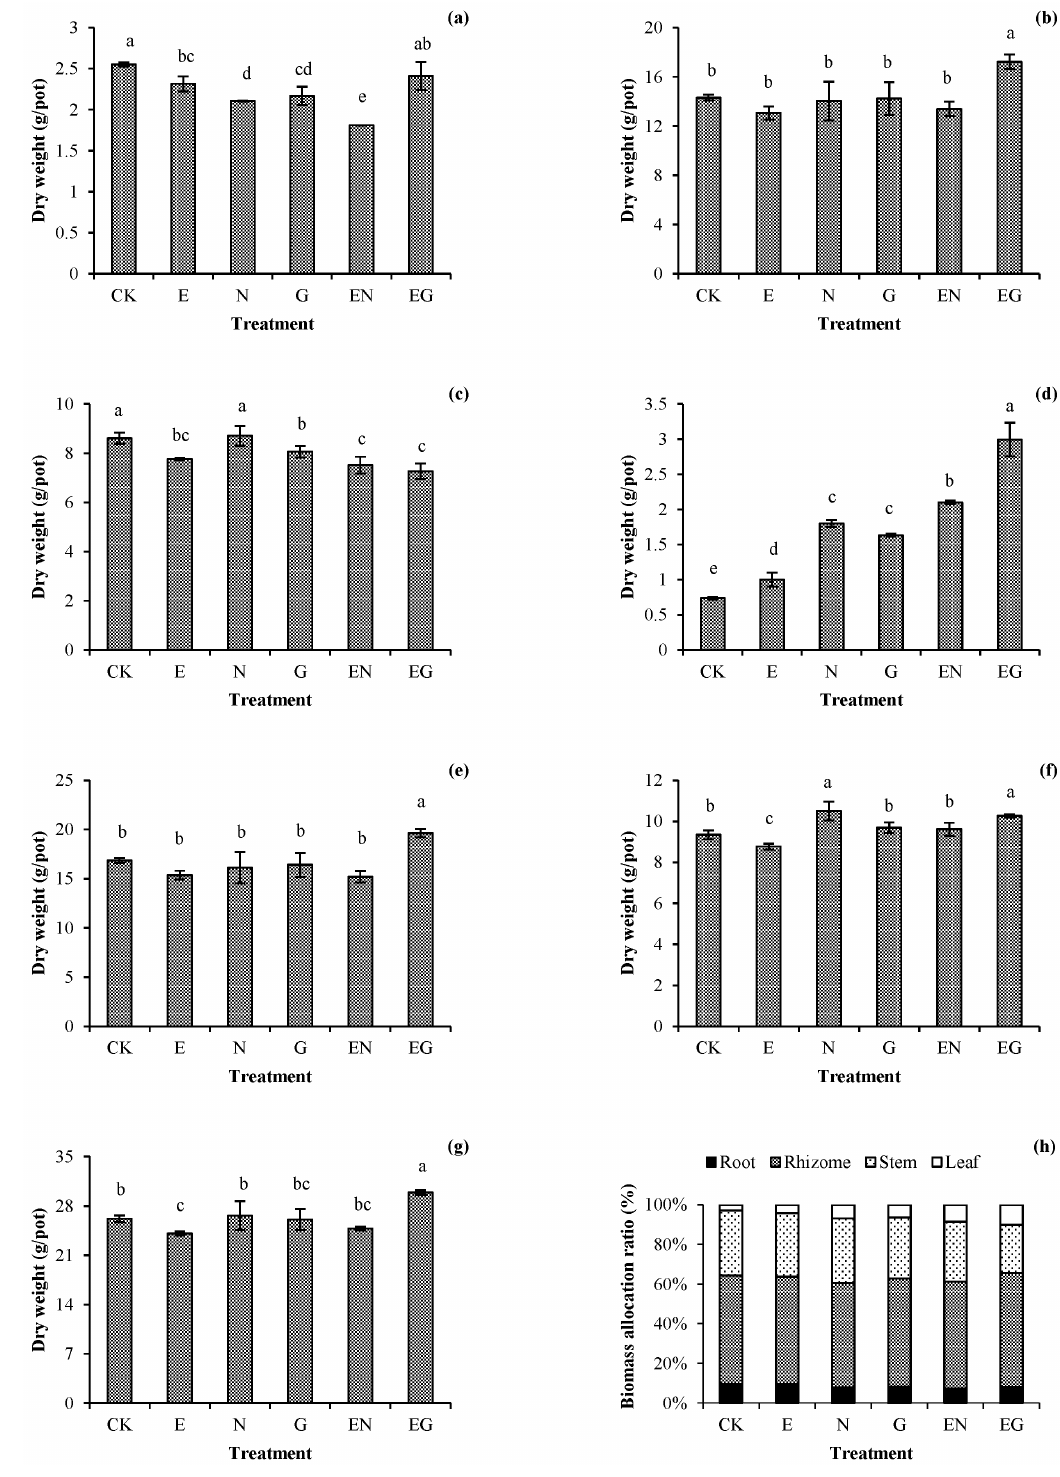
Figure 1. Effects of the different treatments on the ( a ) root, ( b ) rhizome, ( c ) stem, ( d ) leaf, ( e ) under- ground part, ( f ) aerial part, ( g ) total dry weight, and ( h ) biomass allocation ratio of dwarf bamboo. Error bars represent the standard deviations (SDs) of the means ( n = 3). According to Duncan’s multiple range test, different letters above the bars indicate significant differences ( p <